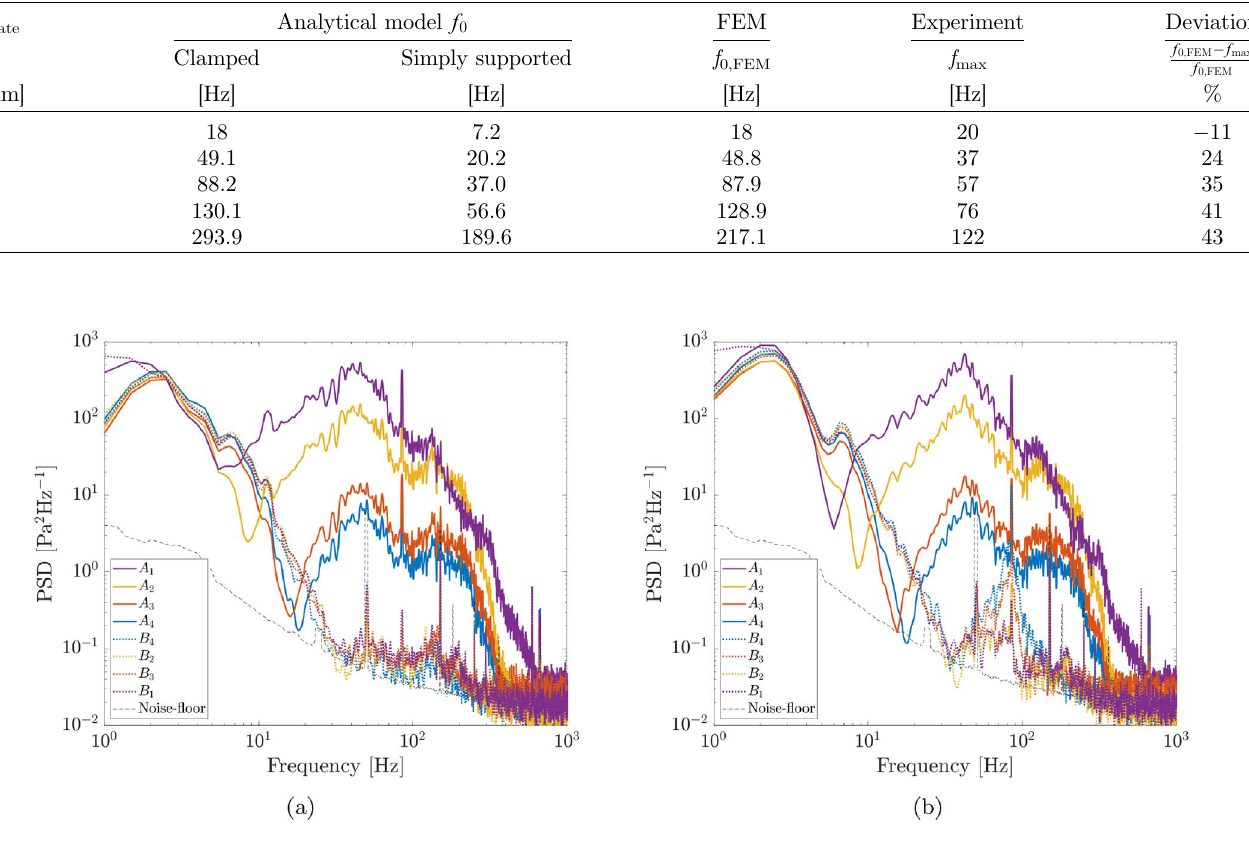
Figure 3. Power spectrum density plots of acoustic pressures measured at source-side (solid lines) and transmission-side microphones (dashed lines) of fl exible-plate resonator with t plate = 2 mm for (a) the 45 m PU tube termination and (b) the closed-end termination on the transmission-side. At the resonance frequency of 37 Hz, the transmitted signal is close to the noise fl